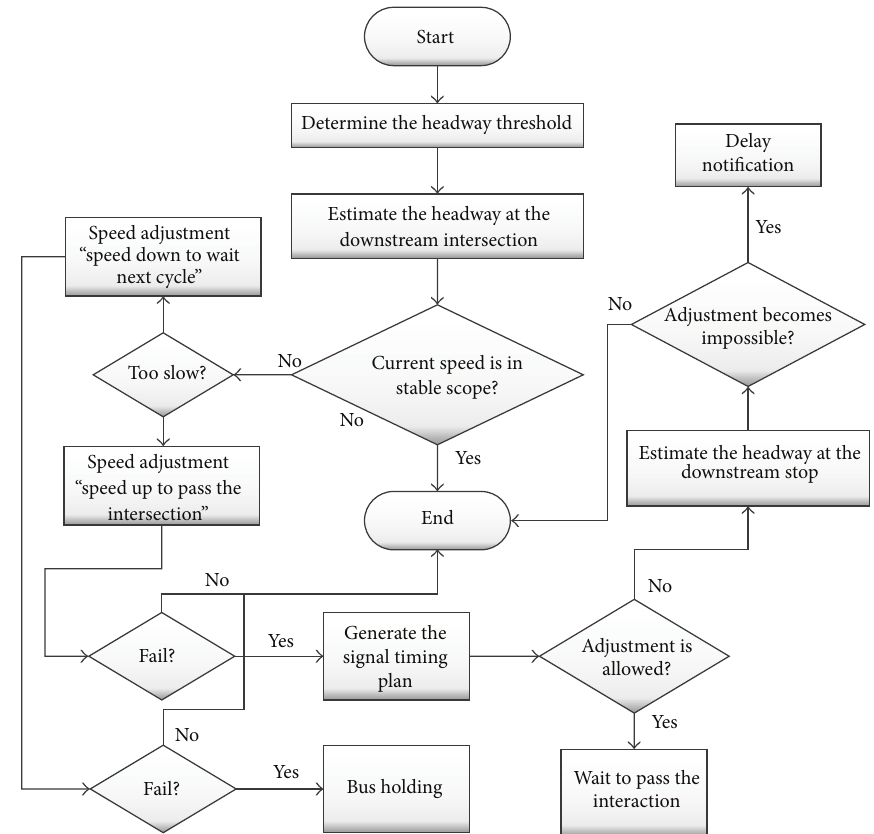
Figure 3: Flow chart of the control